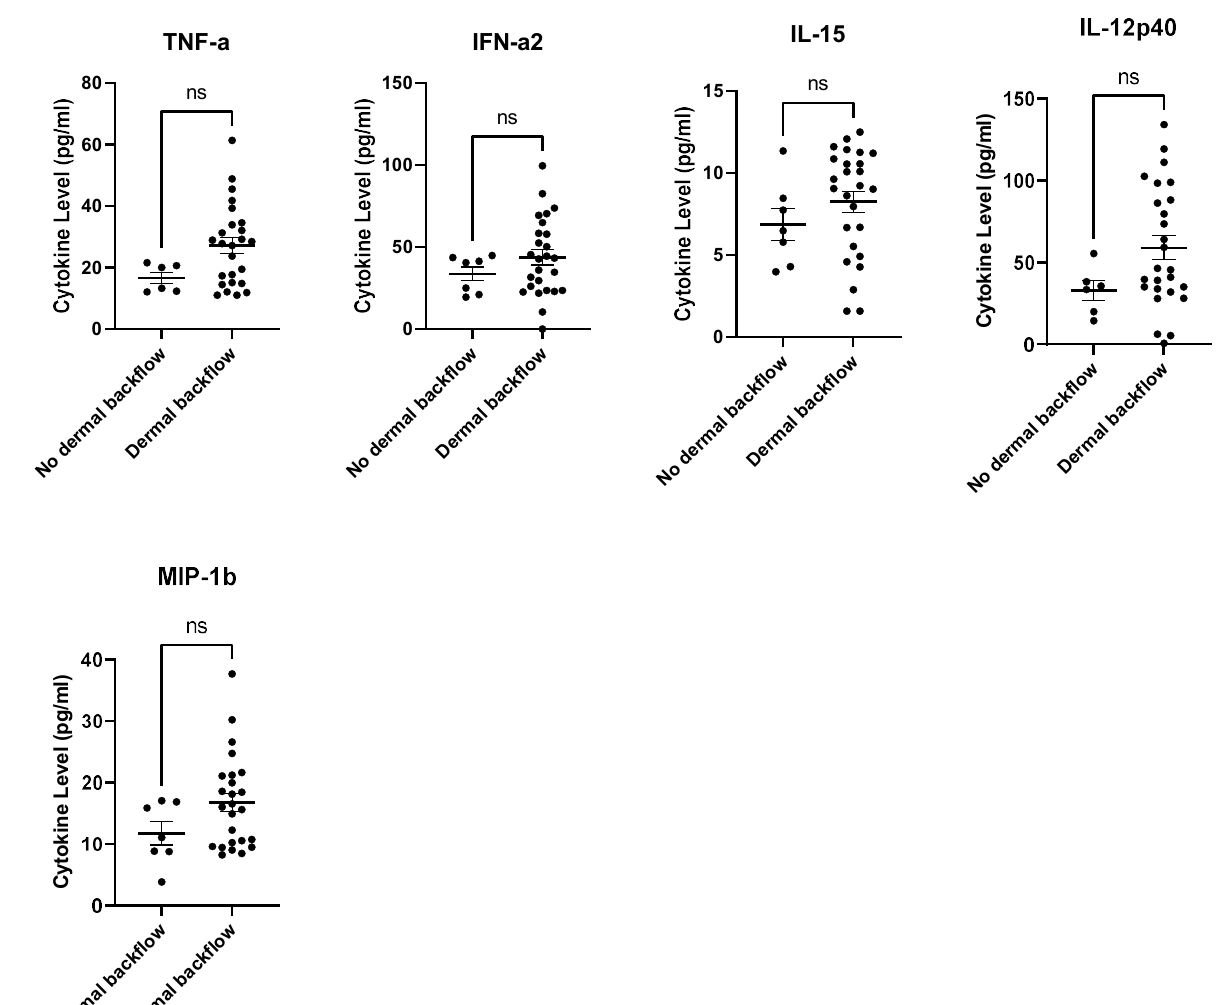
mal Backflow and Clinical BCRL/LE at 12-Months Post-RT GM-CSF, IFN-α2, IL-12p40, IL-15, IL-6, TNF-α, and MIP-1β were significantly higher at the pre-ALND time point in those with both BCRL/LE and dermal backflow at 12- months post-RT in comparison to those who did not develop BCRL or dermal backflow